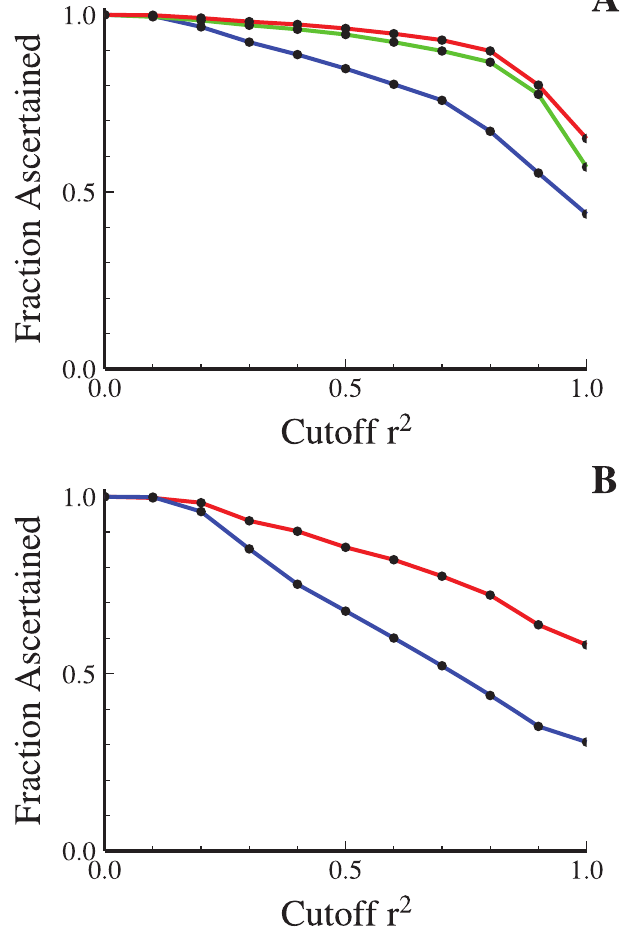
Figure 1. Coverage of the HapMap (A) or SeattleSNPs (B) Datasets As Measured by the Proportion of Common Variation in Each Dataset That Is Captured by a SNP in Either HumanHap550 (CEU; CHB þ JPT) or HumanHap650Y (YRI) at Various r 2 Thresholds Lines show coverage for the CEU (red), CHB þ JPT (green), and YRI (blue)